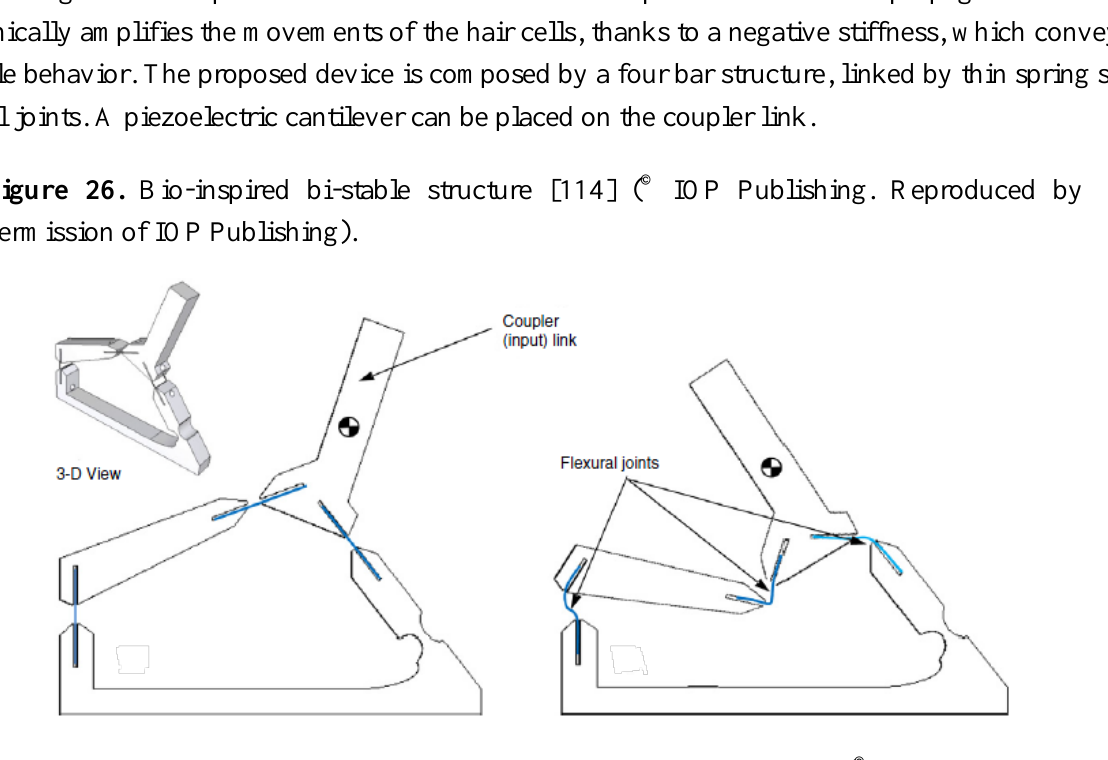
Figure 27. Experimental setup of the bio-inspired harvester [114] ( © IOP Publishing. Reproduced by permission of IOP